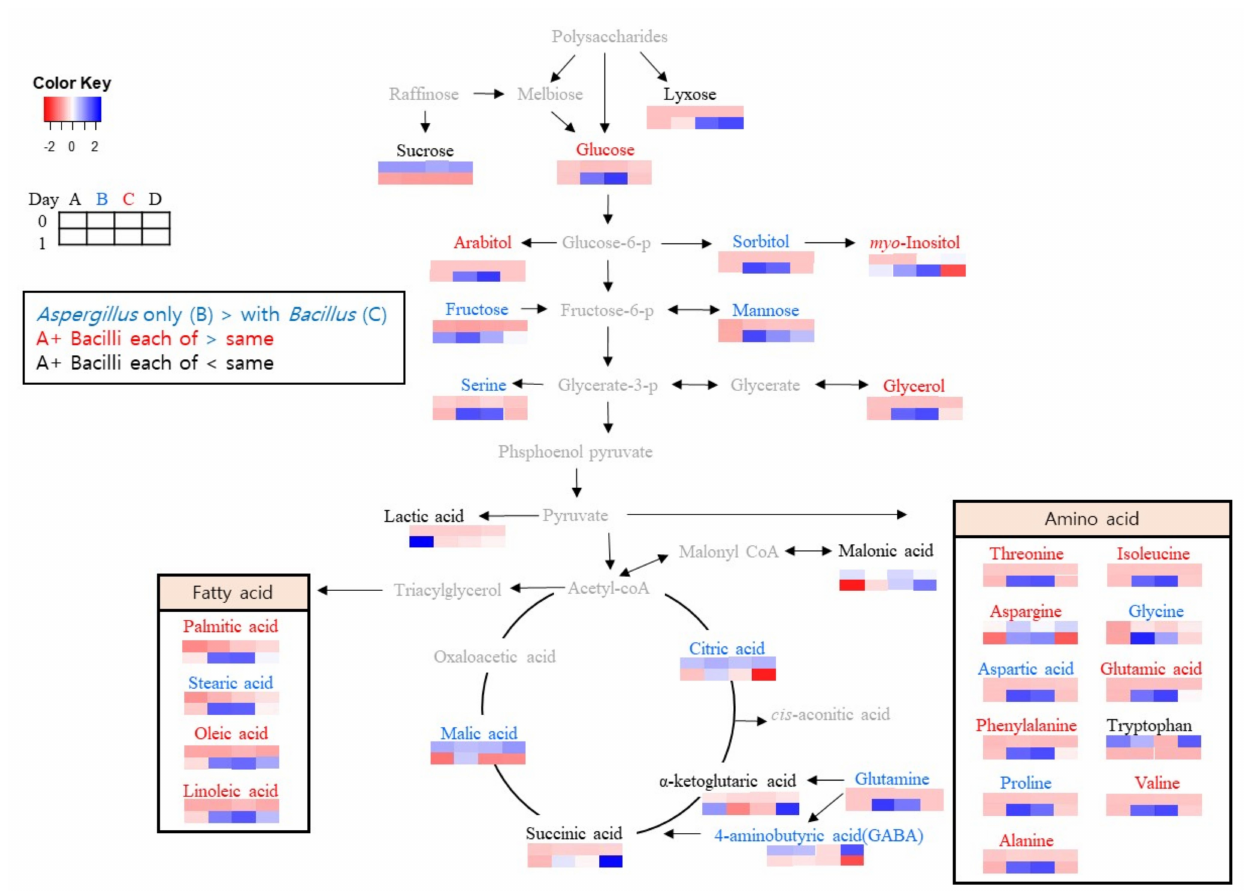
Figure 4. Scheme of a metabolic pathway based on the heatmap generated from GC-MS data from Meju samples reveals metabolic changes during fermentation for 0–24 h among samples using different starters. Metabolite compounds described as color of compound name: Blue, higher levels in Group B inoculated only A. oryzae than in Group C individually inoculated with A. oryzae and B. velezensis ; Red, higher levels in Group C than in Group D co-inoculated simultaneously with A. oryzae and B. velezensis ; Black, higher levels in Group D than in Group